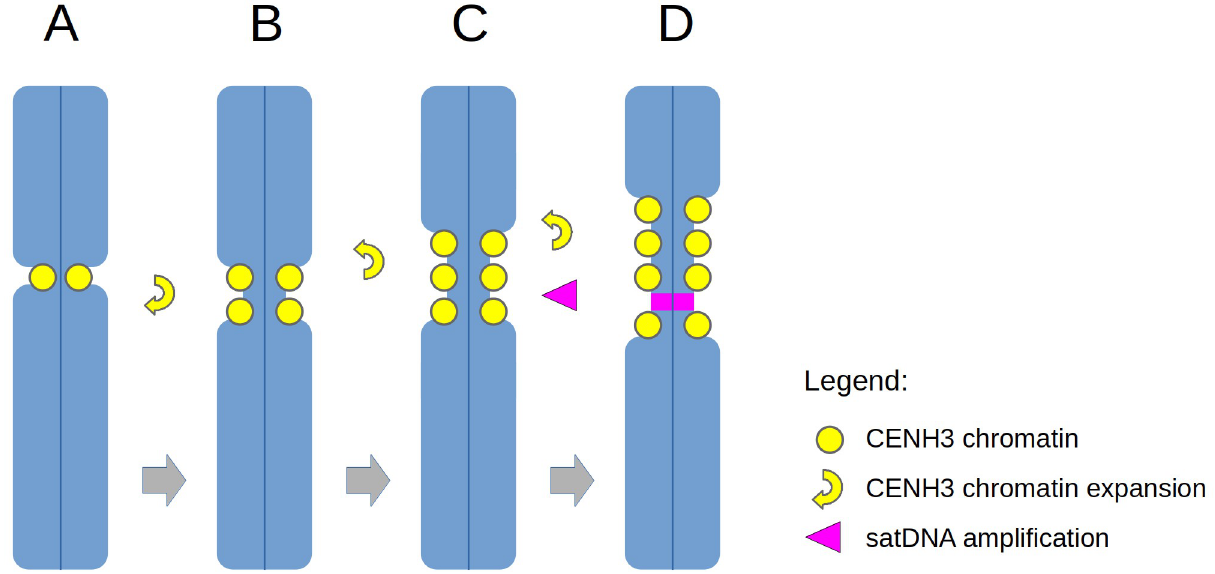
Fig 6. A simplified model of the evolution of metapolycentric chromosomes. A centromere of the ancestral monocentric chromosome ( A ) is expanded by the formation of new CENH3 domains near the original centromere ( B-C ) and the proliferation of satellite DNA ( D ).